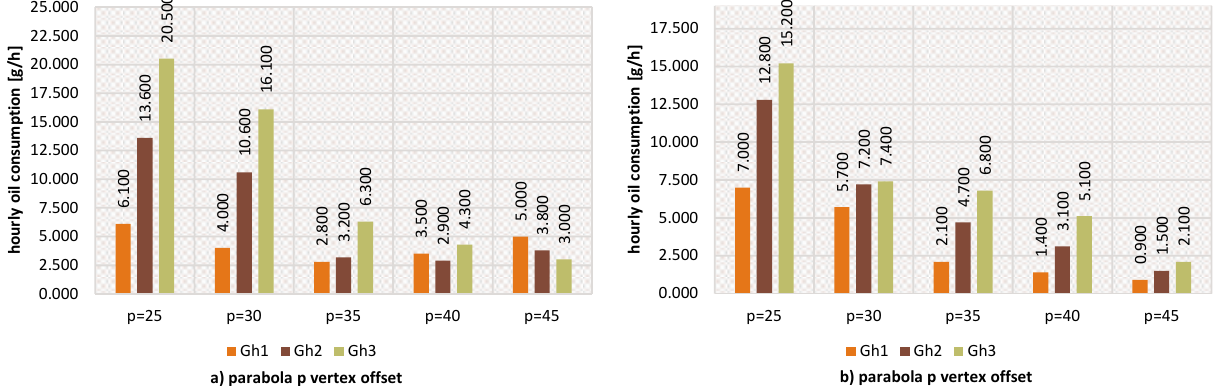
Fig. 6. The hourly consumption of lubricating oil according to the parabolic vertex value of p j,k-1-2 , where: Gh 1 = 1000 rpm, Gh 2 = 2000 rpm, Gh 3 = 3000 rpm; a) for the dynamic viscosity of lubricating oil 0.0120 Pa×s, b) for the dynamic viscosity of lubricating oil 0.0386